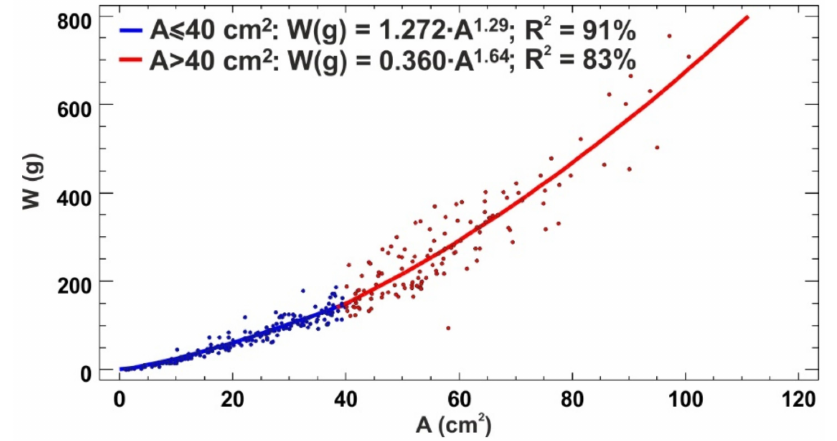
Figure 8. Example of the scatter plot and the corresponding regression lines and equations for the relationship between weight (mass) of the nodules (W) and their surface area (A); based on IOM data for individual nodules; R 2 —coe ffi cient of